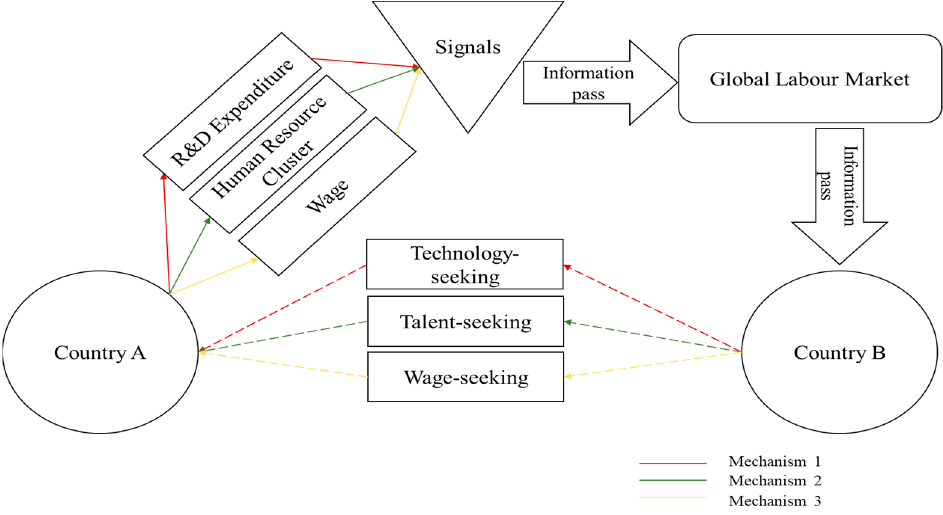
Figure 3. Three mechanisms for attracting high-skilled labor. Source: own illustration based on the reference section.